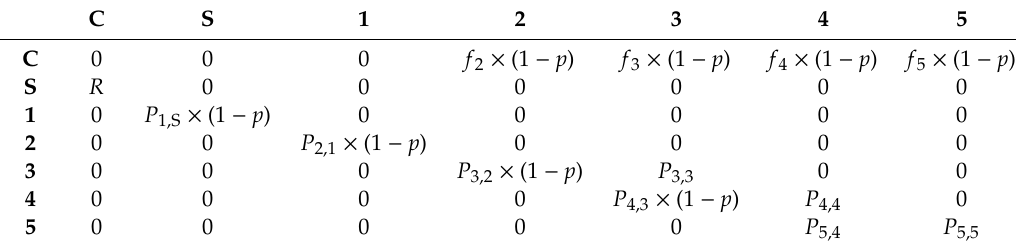
Table 2. Matrix projection model for Pinus radiata with seven classes: cones (C); seeds (S); seedlings (1); small (2), medium (3), and large saplings (4); and mature trees (5). Pitch canker disease ( p ) is represented as a proportion of infected susceptible tissue and a ff ects mortality in smaller size classes and fecundities by killing branch whorls; it may be constant over time or oscillate according to di ff erent disease models. Values for transition probabilities between size classes ( P i,j ) and fecundities ( f j ) were derived from data acquired from a native P. radiata forest on the Monterey Peninsula in